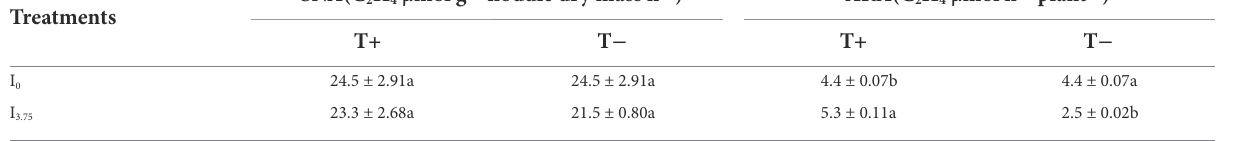
TABLE 5 Effects of unilateral application of isoflavones on nitrogenase activity.